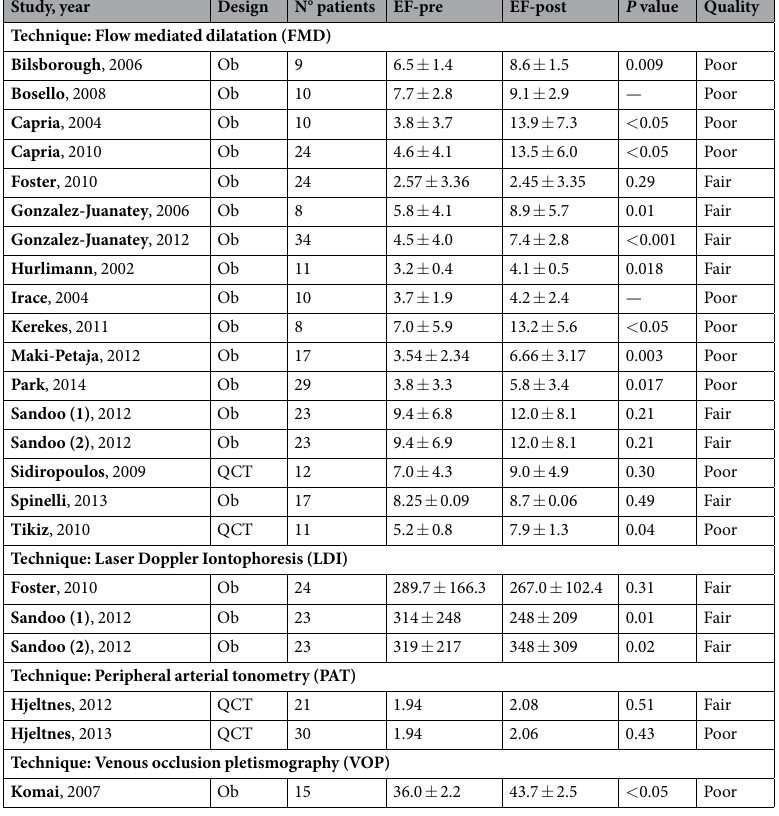
Table 1. Main results of the studies included in the final analysis. Legend: EF, endothelial function; Ob, observational; QCT, quasi-controlled